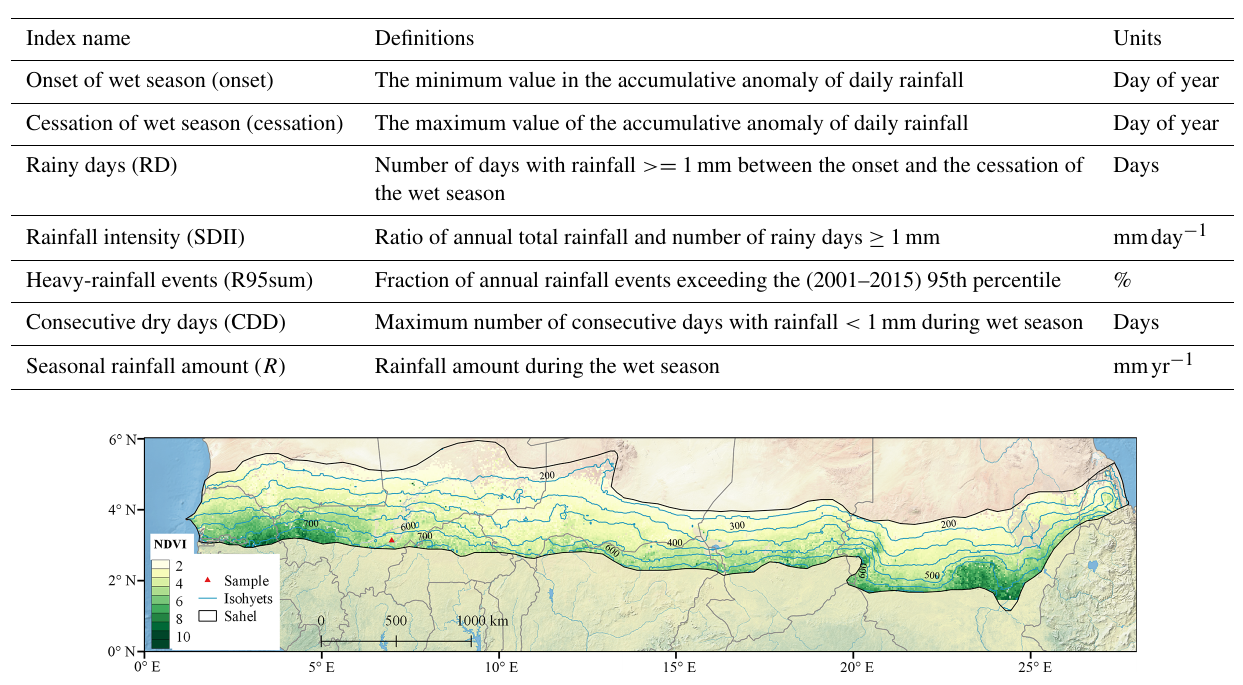
Table 1. Rainfall metrics describing the seasonality and extreme events.